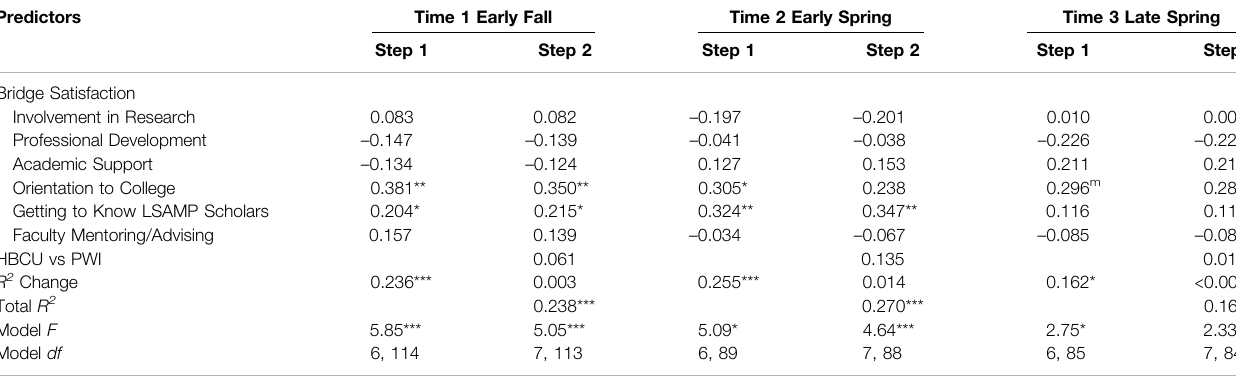
TABLE 4 | Regressions Predicting Total Belonging from Bridge